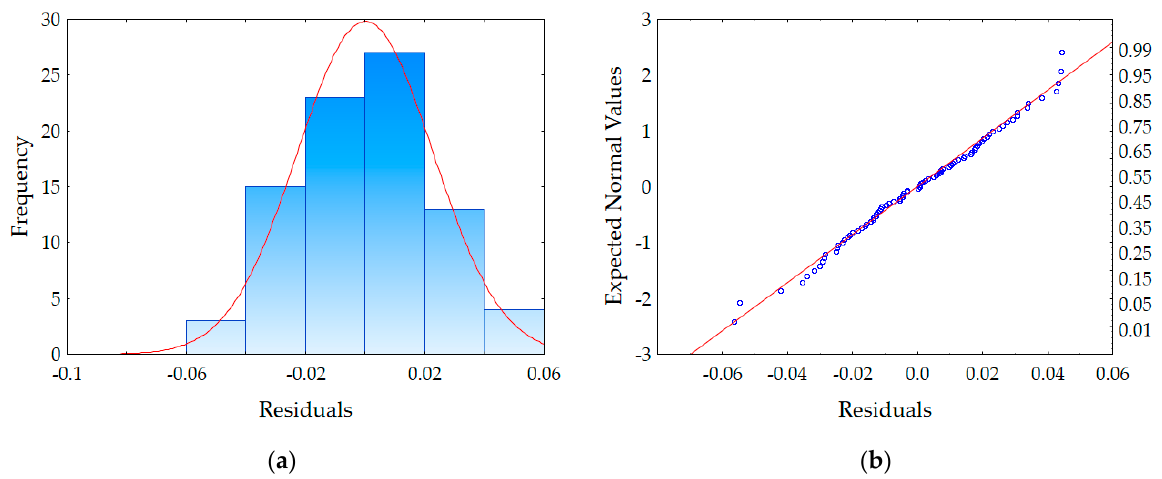
Figure 4. For the best linear effects model: ( a ) residual frequency; ( b ) residual normal quantile plots. Strong variant: DBH alone explained 43% and MDR alone 34% of the variation in wood density (WD) (Table 11, Model 1 and Model 2). Therefore, both DBH and MDR explained 50% of the variation in wood density (Table 11, model 3), indicating that the relationship between drill resistance and wood density is influenced by changes in DBH